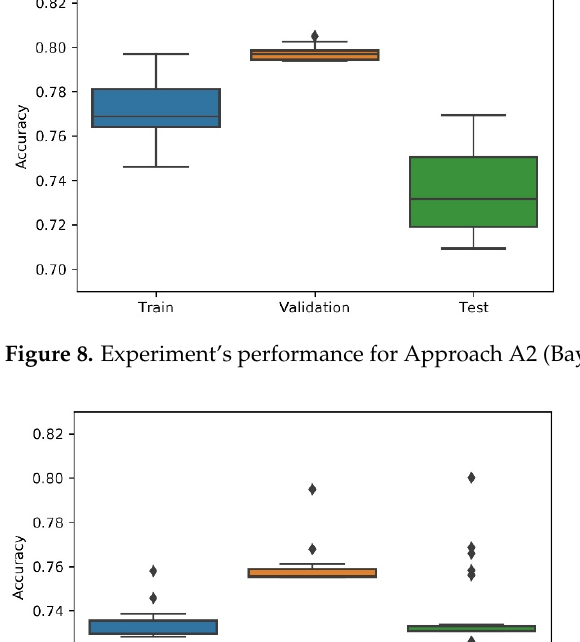
Figure 10. Experiment’s performance for Approach A4 (Random) accuracy (in %). Figure 11. Experiment’s performance for Approach B (Genetic) accuracy (in %). The second measure defined as relevant for monitoring was the execution time. The execution time was obtained by measuring the execution time of the algorithm from the initial start of the algorithm to the result consisting of the best network found. Recall for the NAS settings, namely 200 epochs, 400 max trials, 20 generations, and a population size of 20 samples. Tables 6–10 shows a summary of the execution times for each scenario.